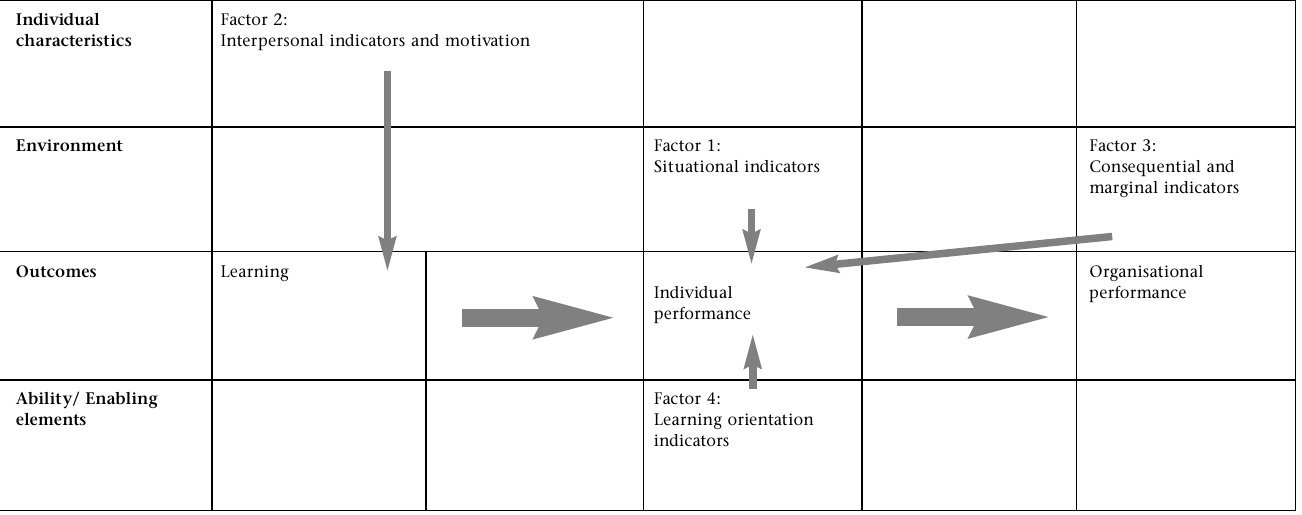
Figure 1: Adapted